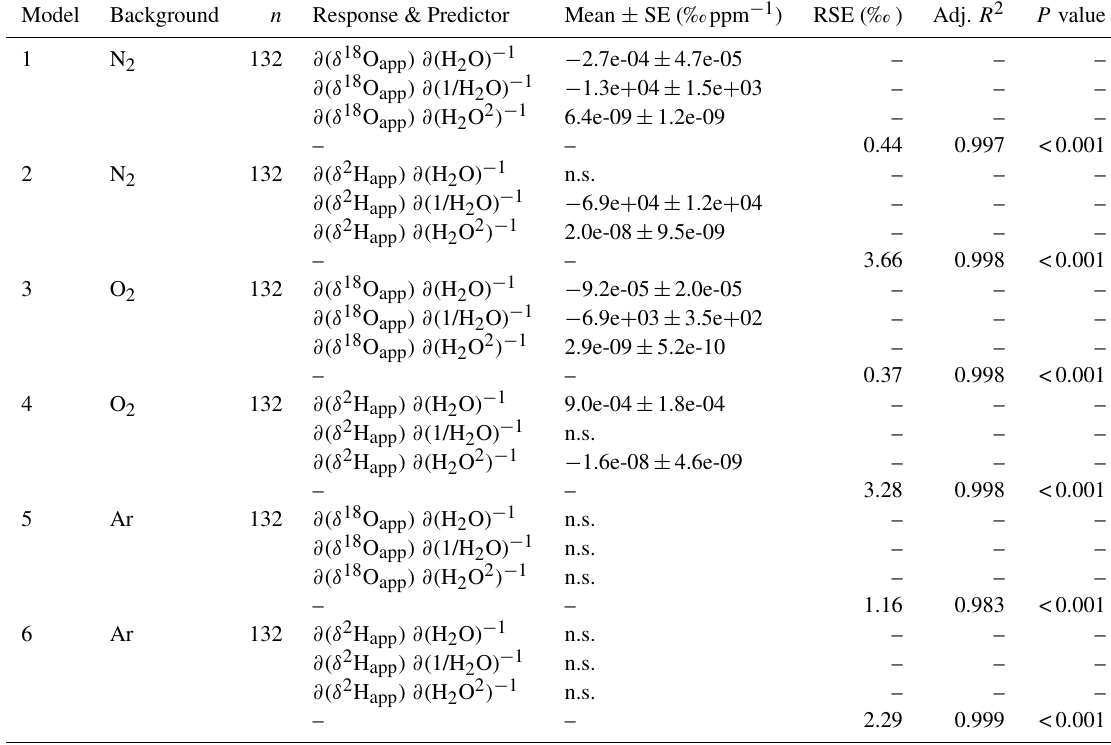
Table 1. Empirical models of the sensitivity of δ 18 O and δ 2 H values to H 2 O in pure N 2 , O 2 , and Ar. For significant predictors, coefficient estimates are given for β 2 , β 3 , and β 4 in Eq. (3); see text. Overall model fit is summarized with the residual standard error (RSE), adjusted R 2 , and P value. The abbreviation n.s. means not significant.